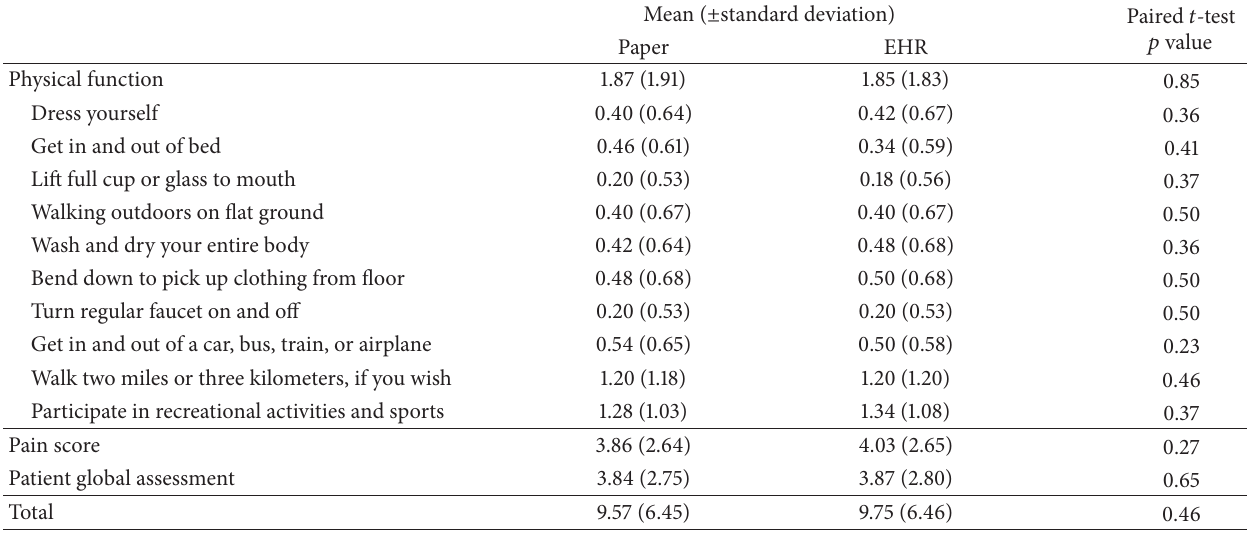
Table 1: Comparison of paper and electronic health record versions of RAPID